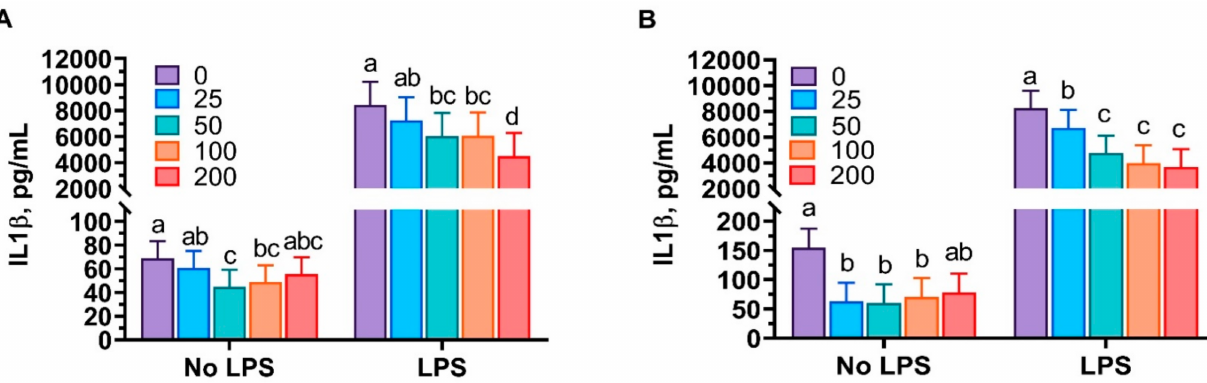
Figure 2. Peppermint oil ( A ) and spearmint oil ( B ) influenced the production of interleukin 1 beta (IL1- β ; pictogram per milliliter) from porcine alveolar macrophages (PAMs) in the absence or presence of lipopolysaccharide (LPS). Cells were incubated with various concentrations (0, 25, 50, 100, 200 µ g/mL) of each essential oil extract in the presence or absence of LPS (1 or 0 µ g/mL) for 24 h. The results were means of values from 6